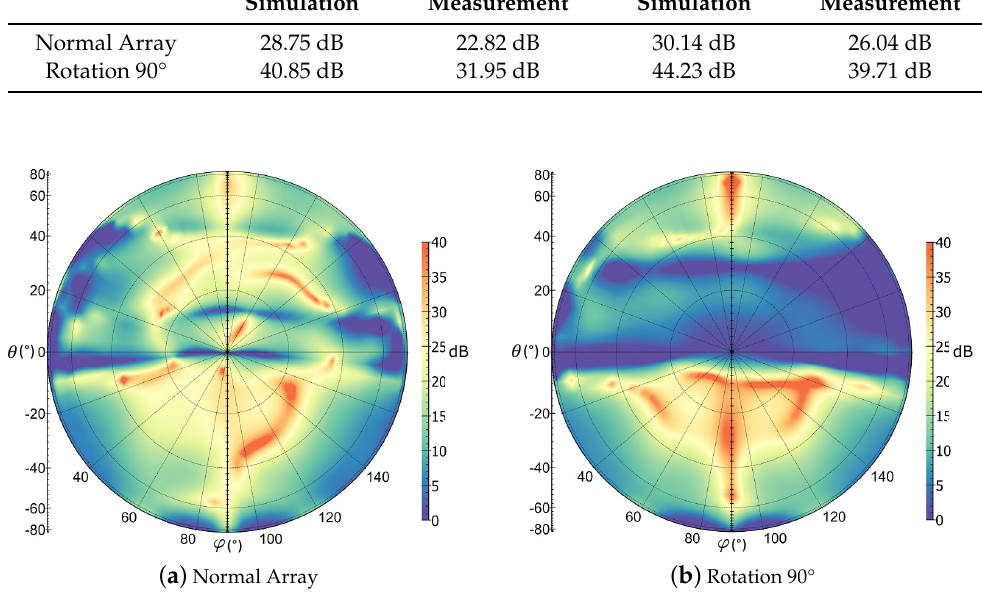
Figure 18. Measured cross-polar suppression @ f 0 = 1.325 GHz. Beamforming. Vertical polarization.